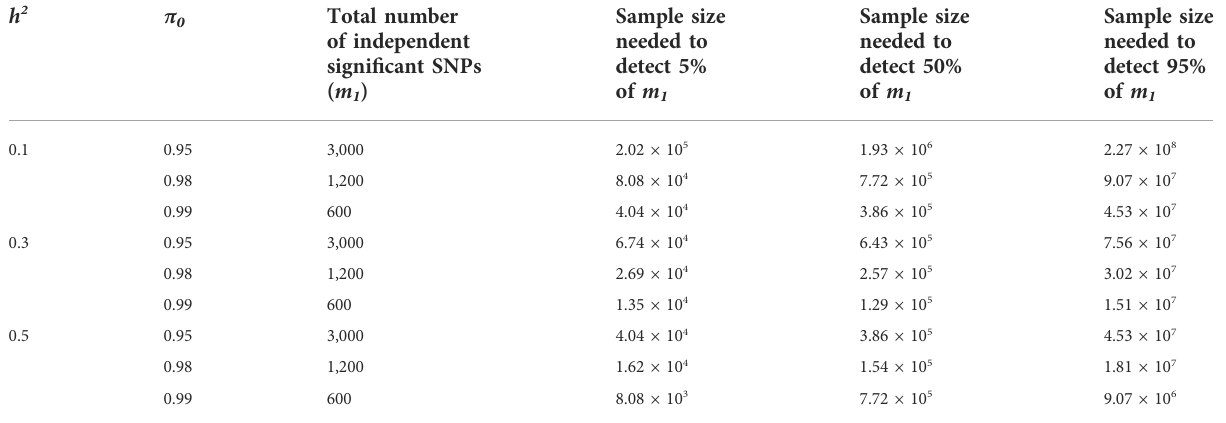
TABLE 3 The sample sizes needed to detect 5%, 50%, and 95% of independent signi fi cant SNPs for phenotypes with different levels of polygenicity, assuming the effect size following point-normal distribution, m = 60,000. m 1 is the total number of causal SNPs. h